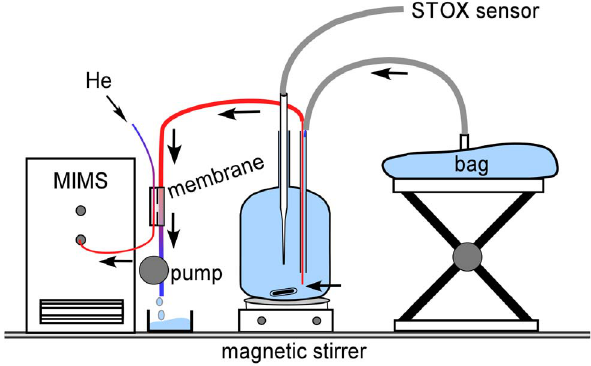
Figure 2. Incubation setup for Experiment 2. Water in the incubation bottle was initially labeled with 18-18 O 2 . The labeled water was pumped with a flow rate of 0.73 mL min 2 1 out of the bottle and across the membrane inlet of the mass-spectrometer. The water was replaced by degassed unlabeled water from a gas tight bag that was positioned at the upper edge of the pressure port to keep a slight overpressure. Helium was used as carrier gas for stable and fast mass